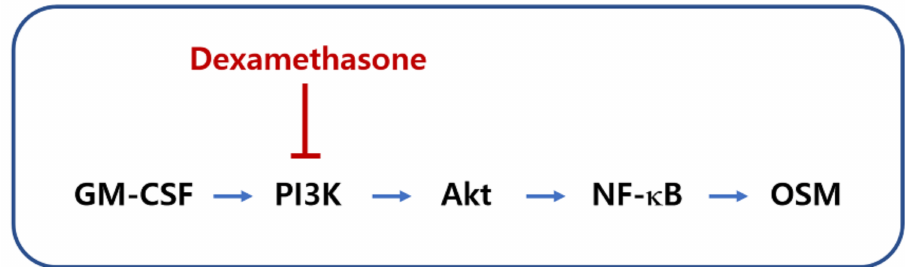
Figure 7. A schematic diagram of the proposed regulation of OSM by